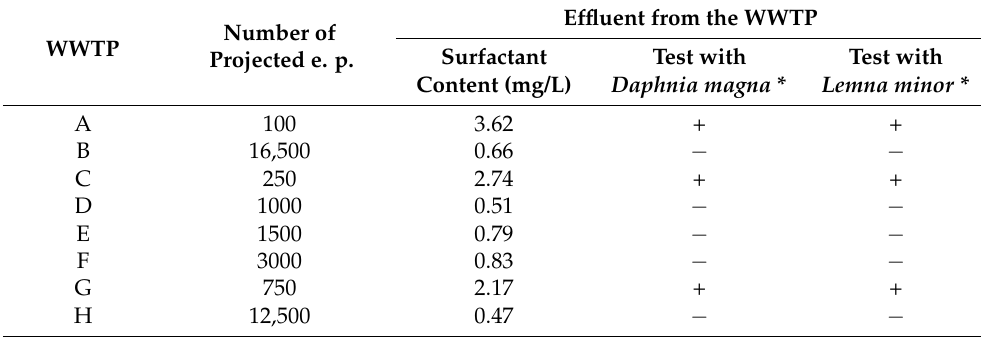
Table 8. Evaluation of the surfactant content (mg/L) in water samples from conventional WWTP, including ecotoxicological evaluation. Number of WWTP Projected e.